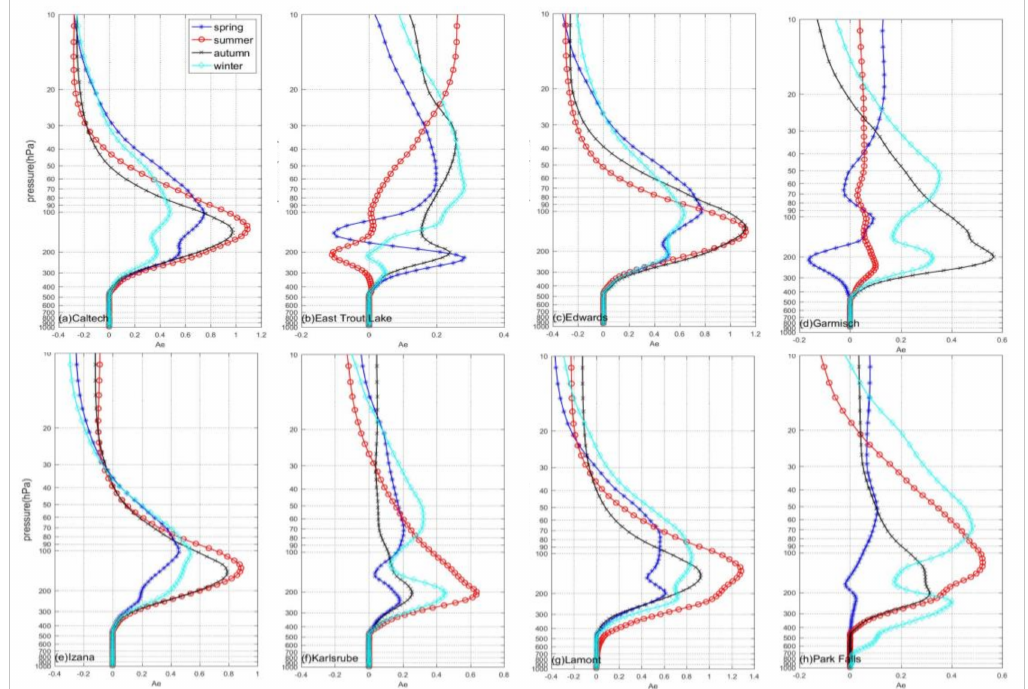
Figure 10. The mean column averaging kernels in different seasons for TCCON stations: ( a ) Caltech, ( b ) East Trout Lake, ( c ) Edwards, ( d ) Garmisch, ( e ) Izana, ( f ) Karlsrube, ( g ) Lamont, and ( h ) Park Falls. The blue, red, black, and turquoise lines represent spring, summer, autumn, and winter,